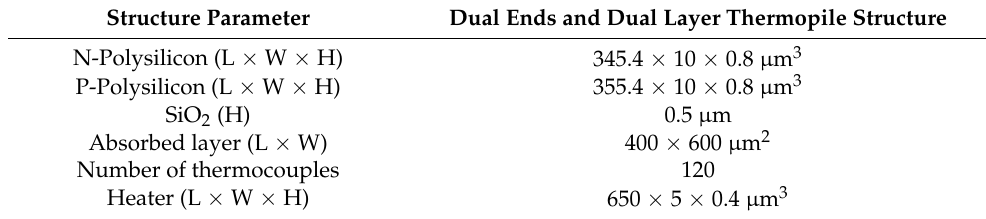
Table 3. Constructional dimension and technical parameter of thermopile